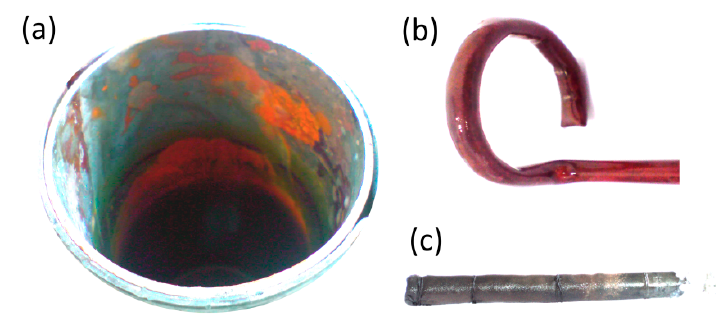
Figure 14. Images of individual construction parts of Model I after the long-term test: ( a ) crucible (cathode), ( b ) air supply pipe, ( c ) separator (anode).